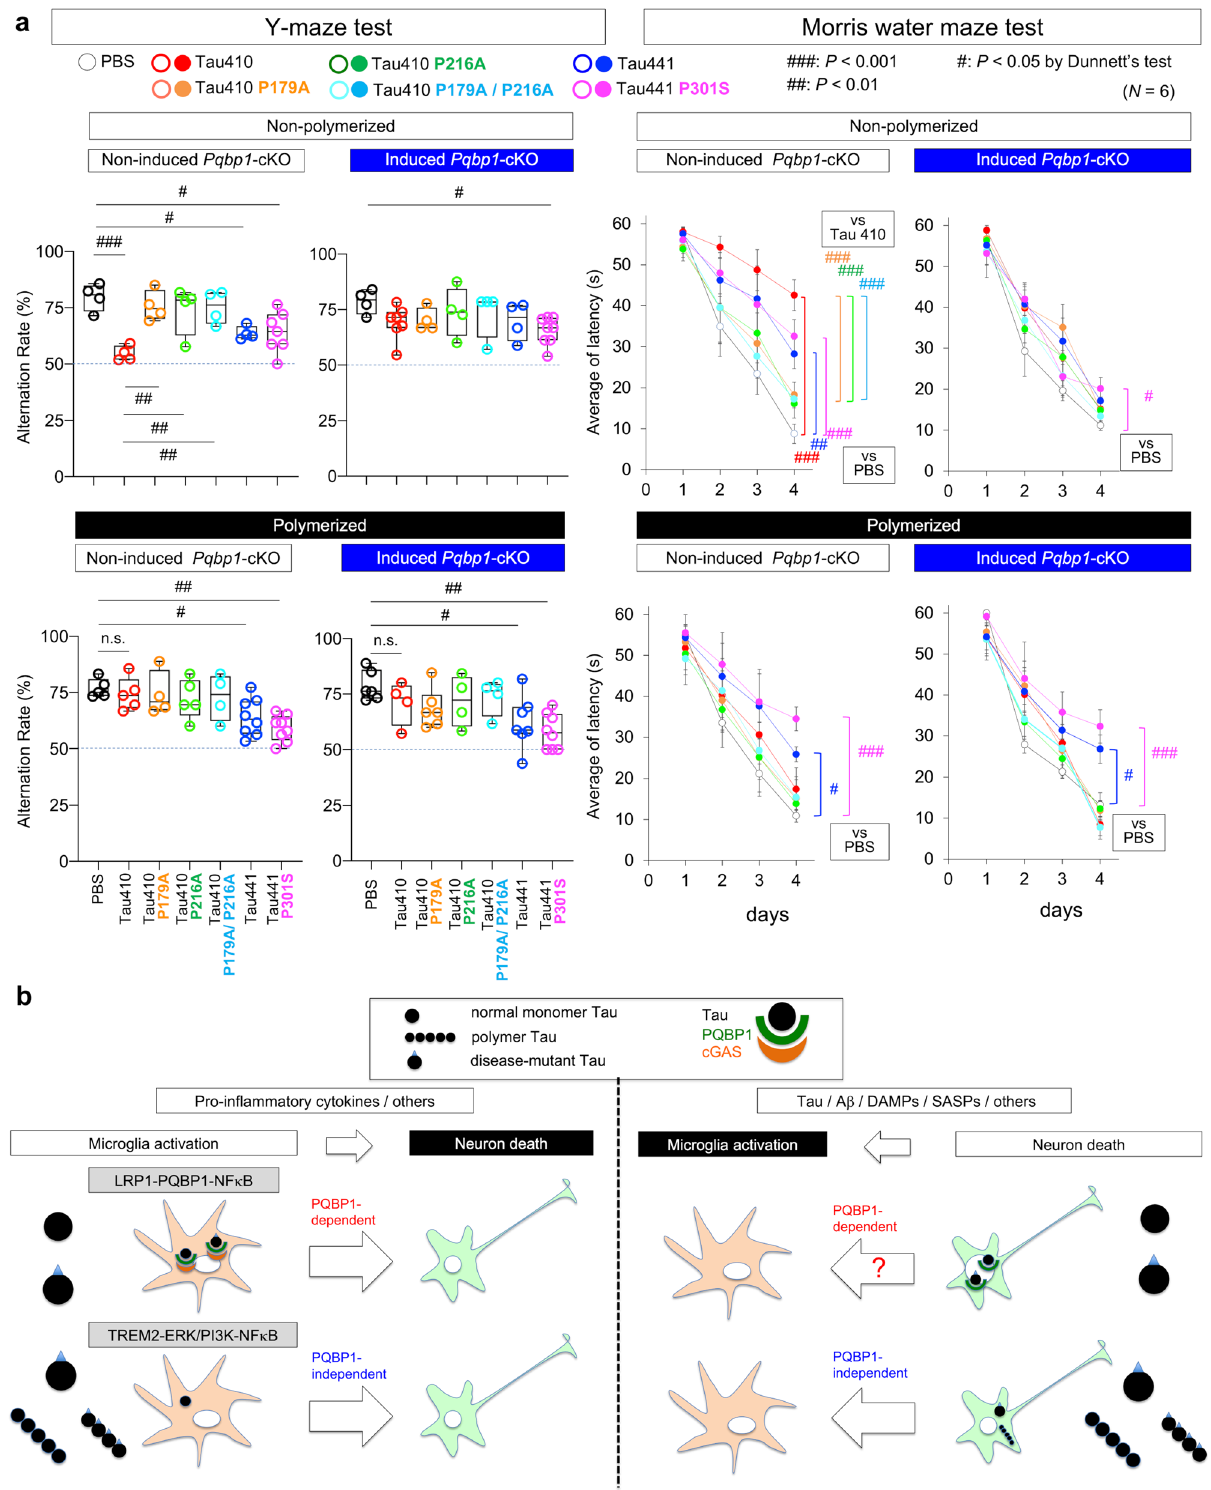
Fig. 10 PQBP1 depletion in microglia recovers memory functions impaired by Tau. a Memory dysfunction after injection of various species of tau in non- polymerized or polymerized state was evaluated by Y-maze test and Morris water maze test. Protocol from injection to memory function tests in various conditions is shown in Fig. 6a. Y-maze test: N number in each group is indicated in Source data. In Morris water maze test, values in each group are presented as mean ± SEM; N = 6 mice/group. # P < 0.05, ## P < 0.01, ### P < 0.001 in Dunnett ’ s test. Box plots show the median, quartiles. and whiskers that represent data outside the 25th to 75th percentile range. b PQBP1-depndent and PQBP1-independent pathways mediating microglia activation to neuronal cell death or neuronal cell death to microglia activation. Different types of tau species trigger distinct